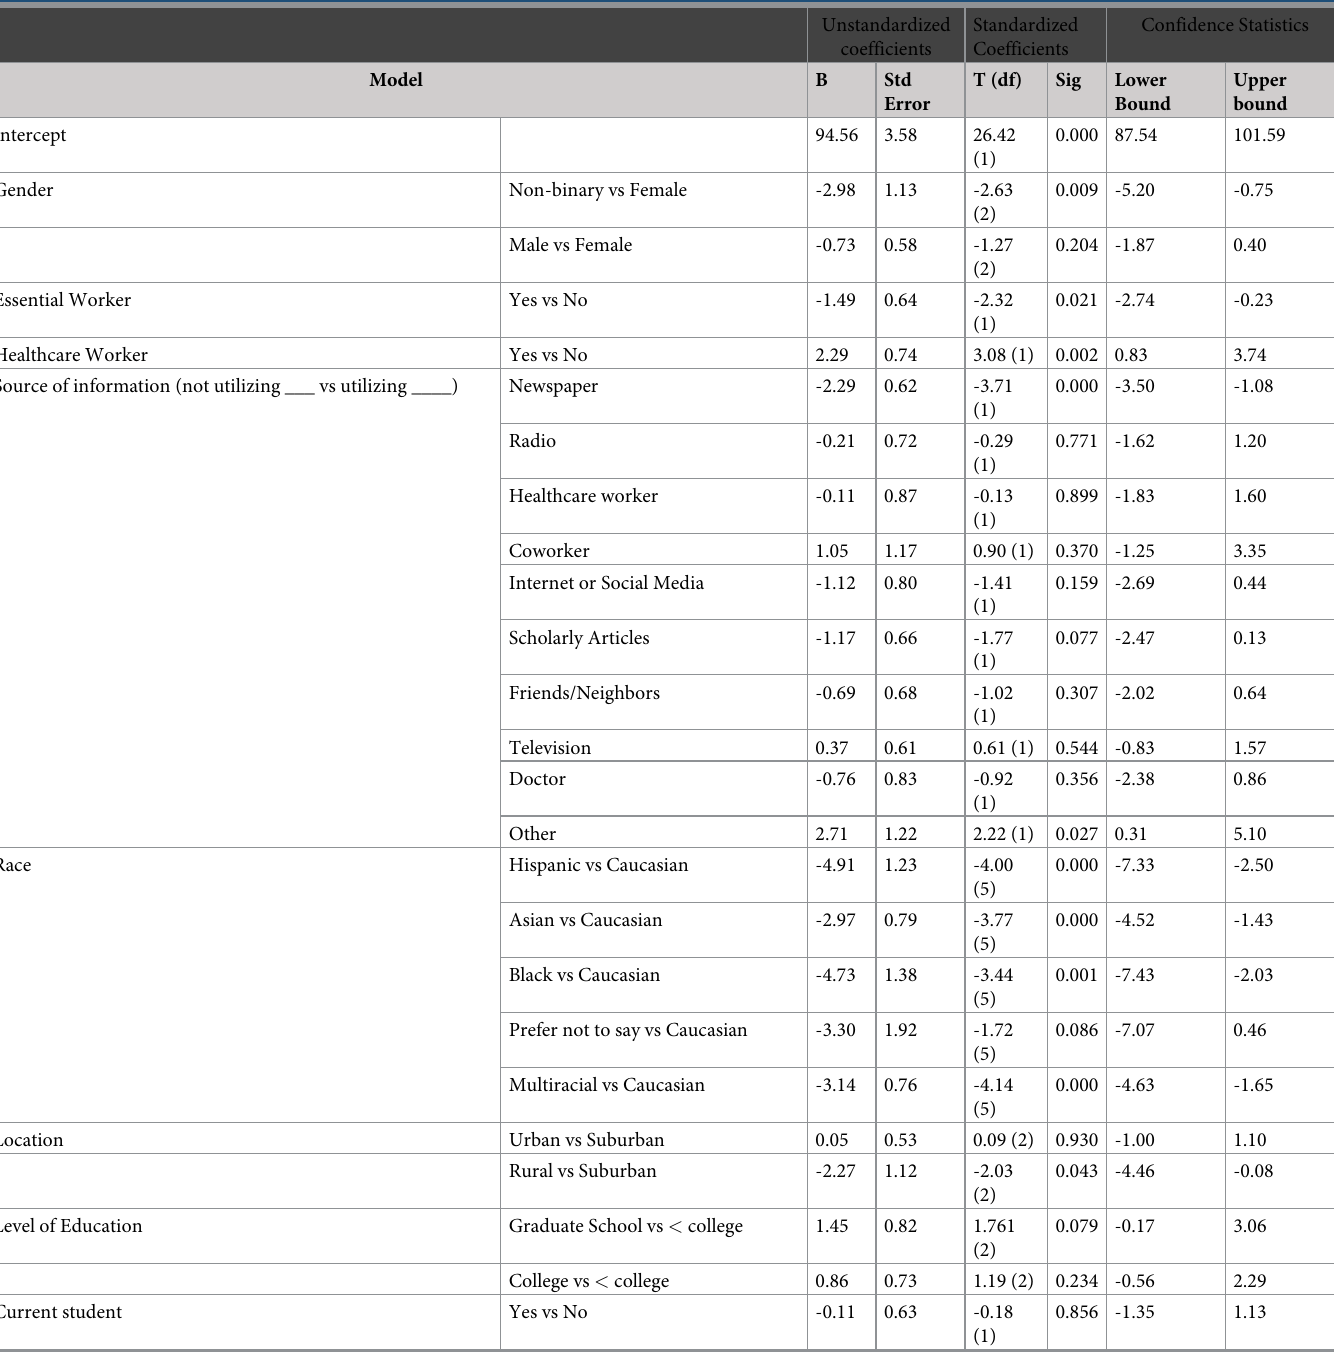
Table 3. KAP multivariate